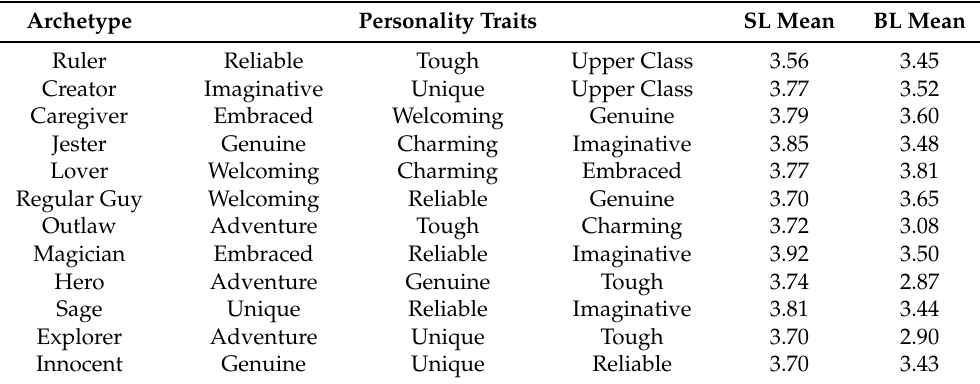
Table 4. Perceived personality traits averages.